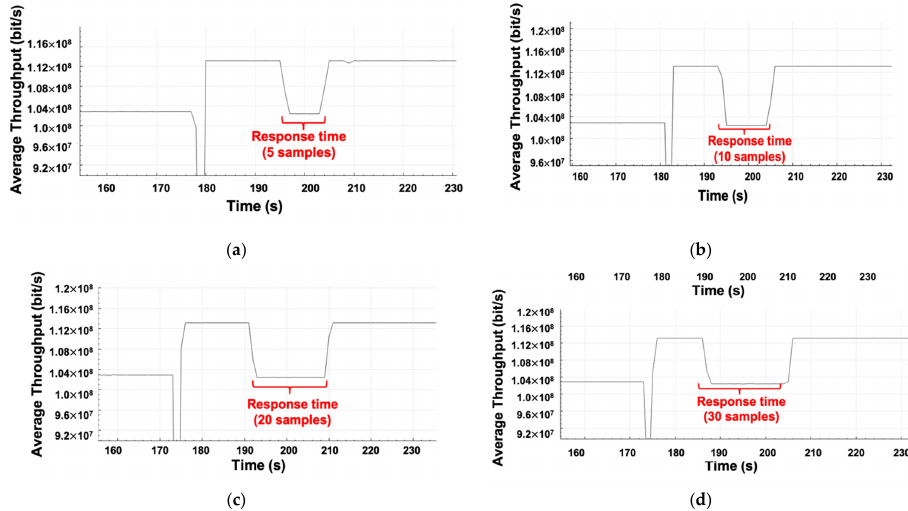
Figure 6. Test done on the size of the sliding window: ( a ) Five samples; ( b ) 10 samples; ( c ) 20 samples; ( d ) 30 samples. However, a too small window can be more sensitive to possible transmission peaks and fluctuations, as it can be seen in Figure 7. As a consequence, to test our dynamic ser- vice reconfiguration algorithm, a 10-samples window is chosen since the delay and the fluctuations are low and its performance is quite similar to high window sizes (20/30 sam- ples).